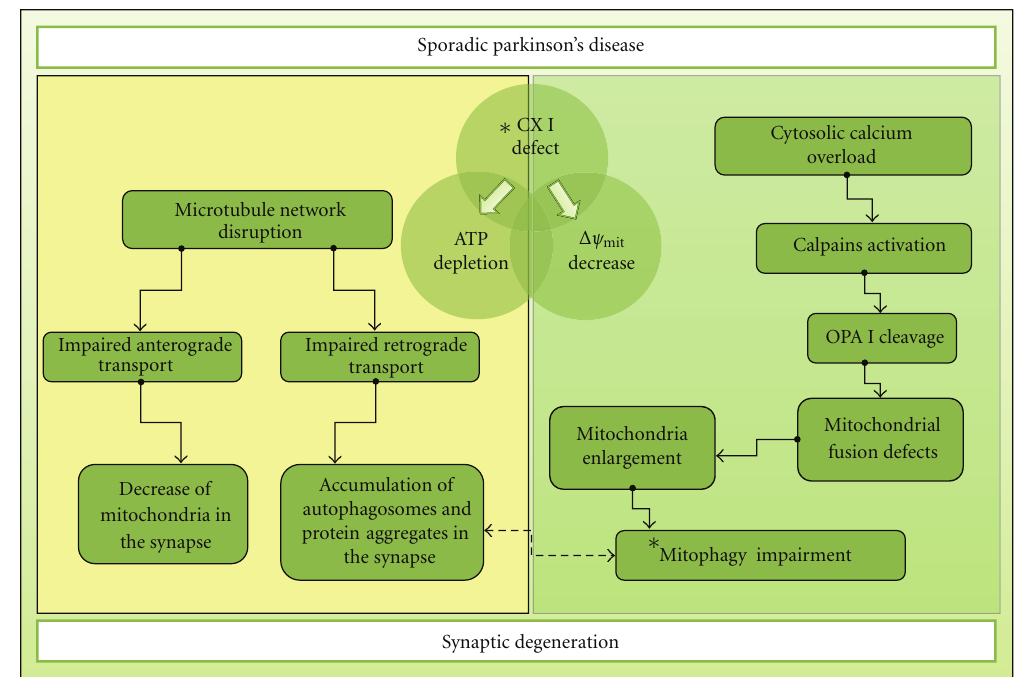
Figure 2: Rationale for the contribution of mitochondrial dysfunction to synaptic degeneration in sporadic PD. Mitochondrial dysfunction induced by a complex I defect leads to alterations in mitochondria-dependent metabolism (reduced ATP levels and decreased mitochondrial inner membrane potential). This bioenergetic failure seems to potentiate microtubule network breakdown. Subsequently, when the dynamics and functional integrity of microtubules are compromised, changes in anterograde and retrograde flux along the axon can be impaired. Cargos that are actively transported along the axon include mitochondria, autophagosomes, and proteins. Moreover, a decrease in mitochondrial membrane potential deregulates calcium homeostasis, which leads to the overactivation of calpains. Calpains are key regulators of mitochondrial fusion, since they impair Opa1 proper function. Alterations in fusion/fission events promote mitochondrial enlargement, which can impair their removal by mitophagy. Indeed, the accumulation of protein aggregates, autophagosomes, and enlarged deficient mitochondria in presynaptic termini is observed at early stages of PD. Our hypothesis implies that mitochondrial metabolism impairment could be responsible for synaptic degeneration in PD. ( ∗ Indicates that mutated or overexpressed α -synuclein could induce mitochondrial dysfunction and that loss-of-function of Parkin or/and PINK1 can deregulate mitochondrial